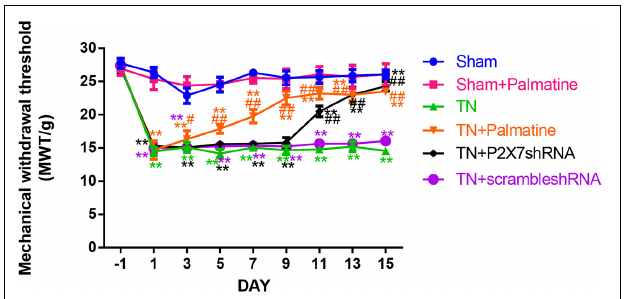
FIGURE 1 | The change of the mechanical withdrawal threshold (MWT) of rats in each group. Values are mean ± SD, n = 6, ** p < 0.01 vs. sham group, # p < 0.05 and ## p < 0.01 vs. TN